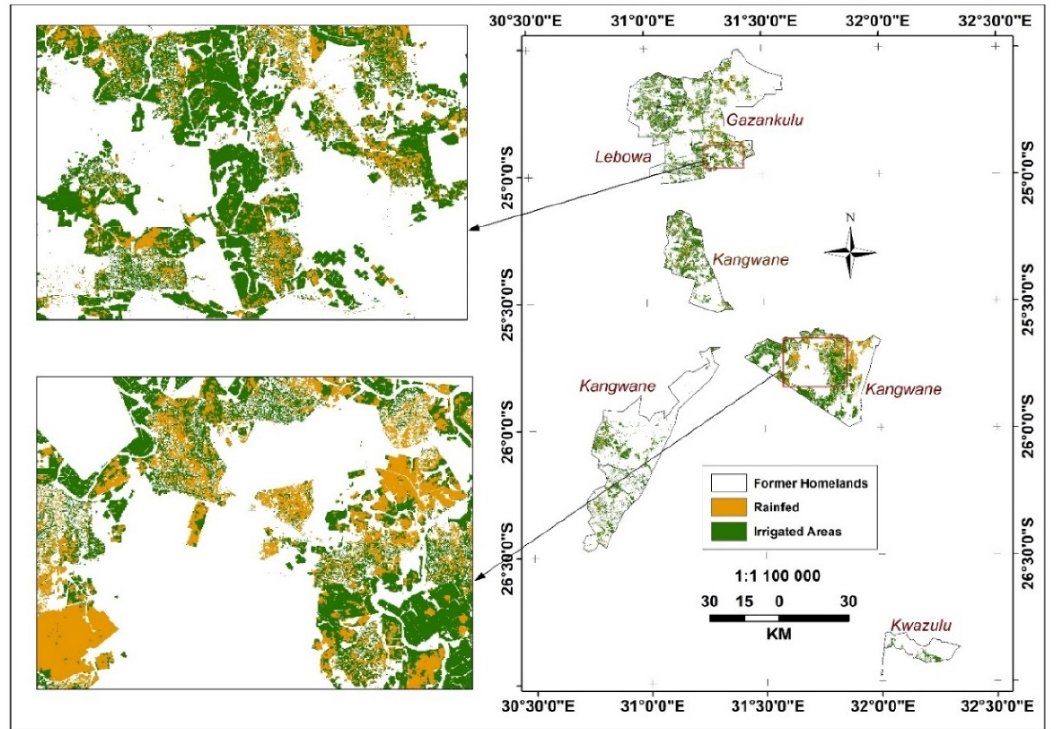
Figure 6. Irrigated and rainfed areas in former homelands in winter 2019.